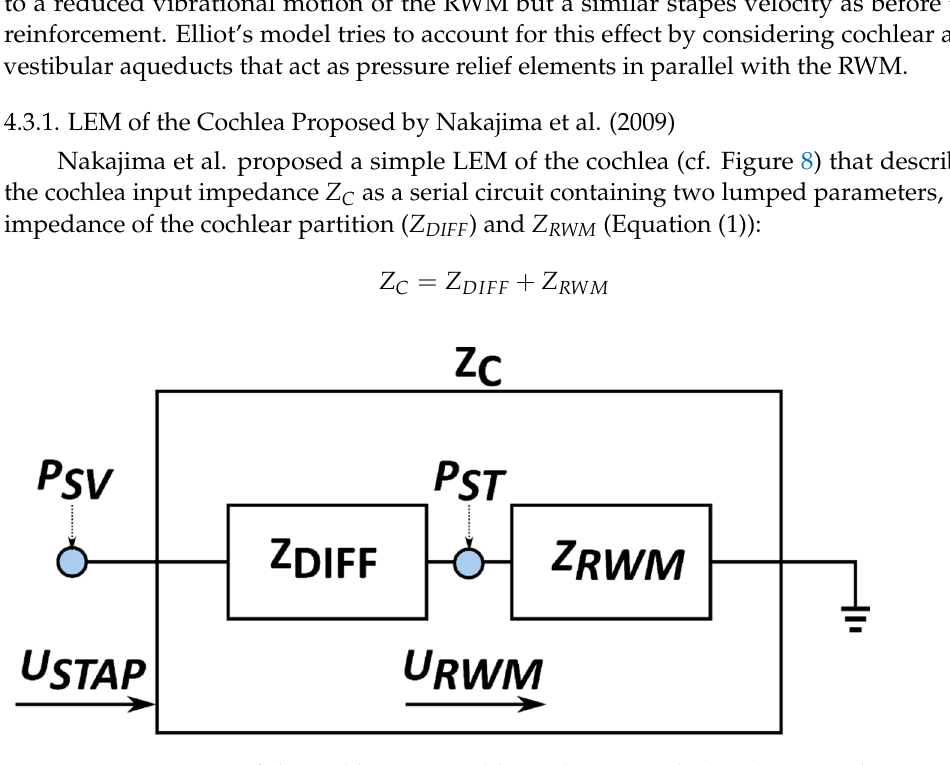
Table 1 Table 1. Parameter values used in Nakajima et al.’s lumped element model (LEM). Lumped Element